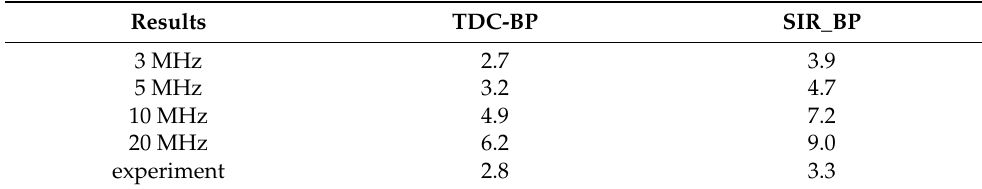
Table 3. The calculated FWHMs improved for the off-center target at x = 4.5 mm reconstructed with different methods and different transducer frequencies in simulation results and experiment result for the off-center target at about 4mm.